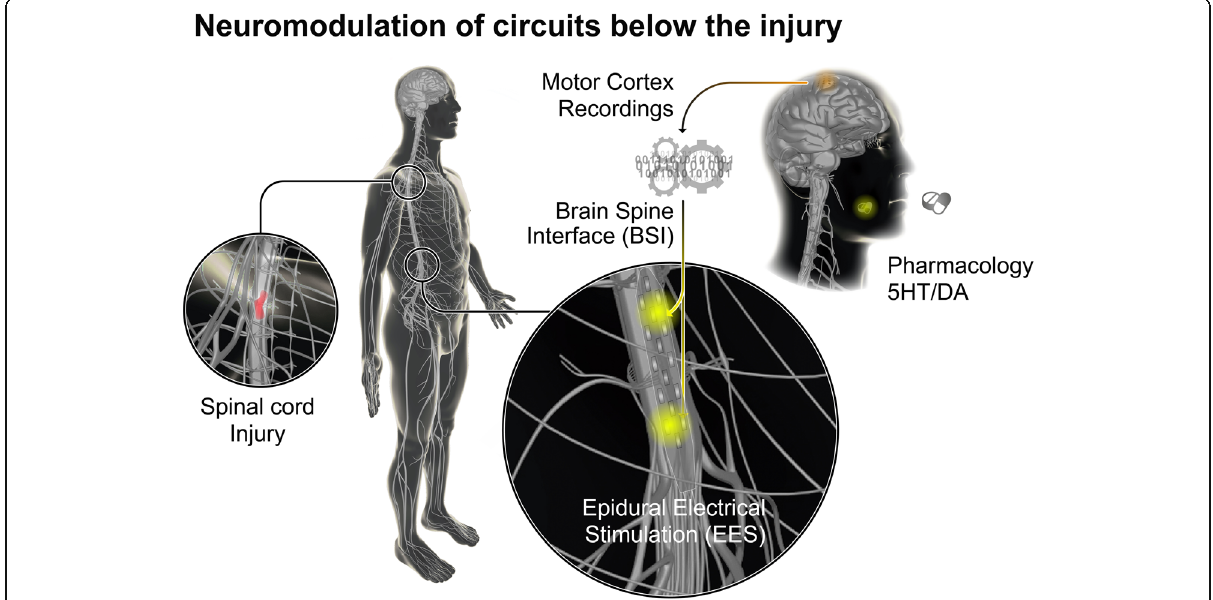
Fig. 1 Neuromodulation strategies to engage circuits below the lesion after SCI. The reactivation or modulation of spinal circuits for locomotion has been demonstrated with the use of epidural electrical stimulation (EES) combined with the oral or intrathecal administration of serotonergic and dopaminergic agonists. EES can also be used to optimize autonomic function post-SCI (i.e., blood pressure management). Brain-spine interfaces (BSIs) also provide an alternative strategy for locomotion through bypassing the